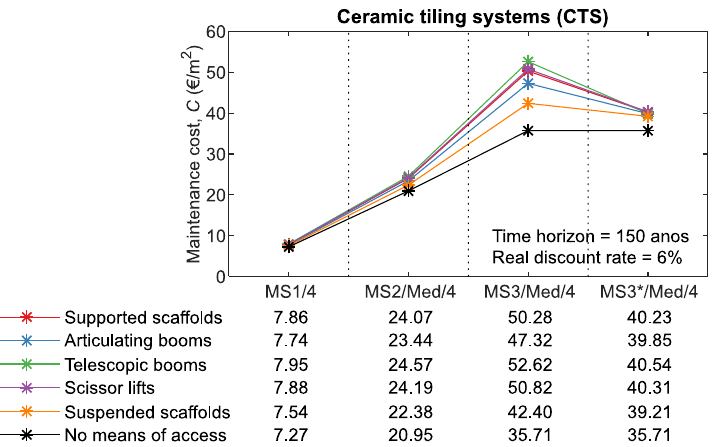
Figure 2. Sensitivity analysis of the different means of access in CTS maintenance strategy costs for a time horizon of 150 years.